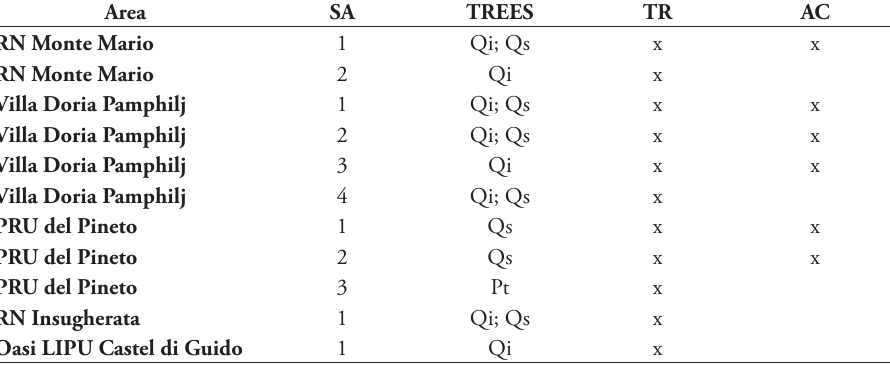
Table 2. Summary of the areas in the province of Rome (Latium, Italy) where the training and the ac- curacy tests were carried out. SA: sub-areas for training sessions; TREES: tree species present in the area and in which the target was hidden (Qi: Quercus ilex ; Qs: Quercus suber ; Pt: Populus tremula ); TR: training areas; AC: accuracy test areas; Oasi = private Nature Reserve; PRU = Regional Urban Park; RN = Nature Reserve; Villa = city park with annexed historical